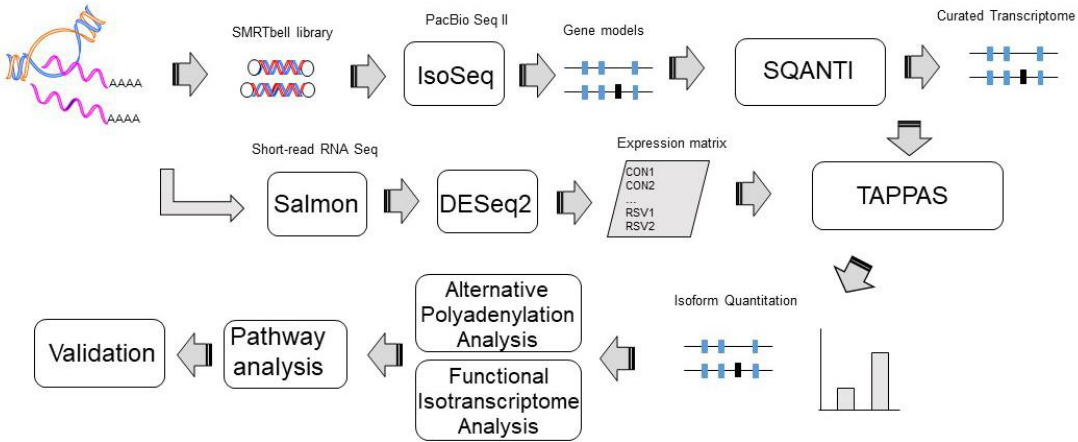
Figure 1. Data analysis pipeline for quantitative mRNA processing. Shown is a schematic representation of the data analysis pipeline for integrating single-molecule, real-time (SMRT) with short-read RNA sequencing analysis. Filtered, polished reads from PacBio Sequel II were pooled from control and respiratory syncytial virus (RSV)-infected hSAECs and used to generate a curated transcriptome, filtering novel not in catalog (NNIC) and RNA transcripts. Short-read RNA transcripts were mapped to hg38 and transcript abundance determined in Salmon 1.3. The curated transcriptome, mRNA expression matrix, and experimental design was used in tappAS to quantify differential isoform utilization (DIU) and analyze differences in